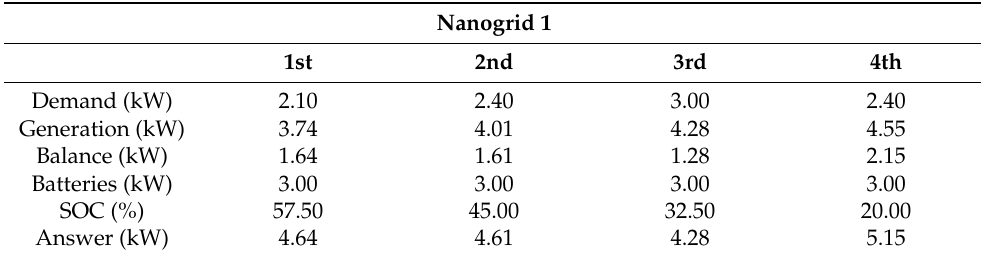
Table 4. Operation planning of HEMS1 in order to provide a